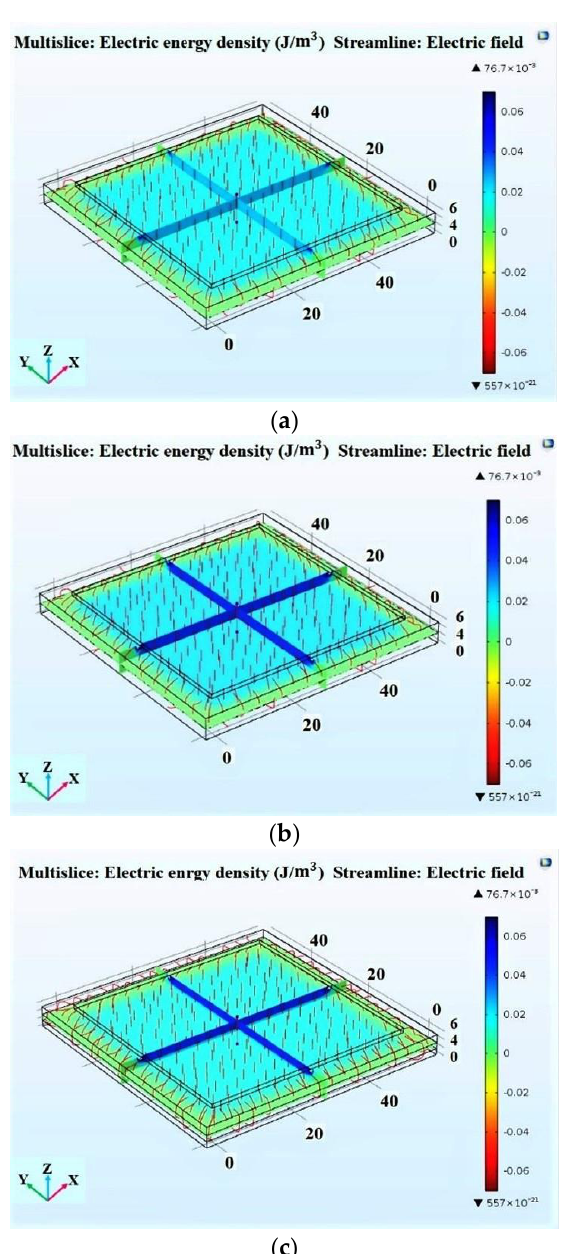
Figure 27. ( a ) Energy transfer density of air and sand. ( b ) Energy transfer density of air and water. ( c ) Energy transfer density of air, sand and water mixture.